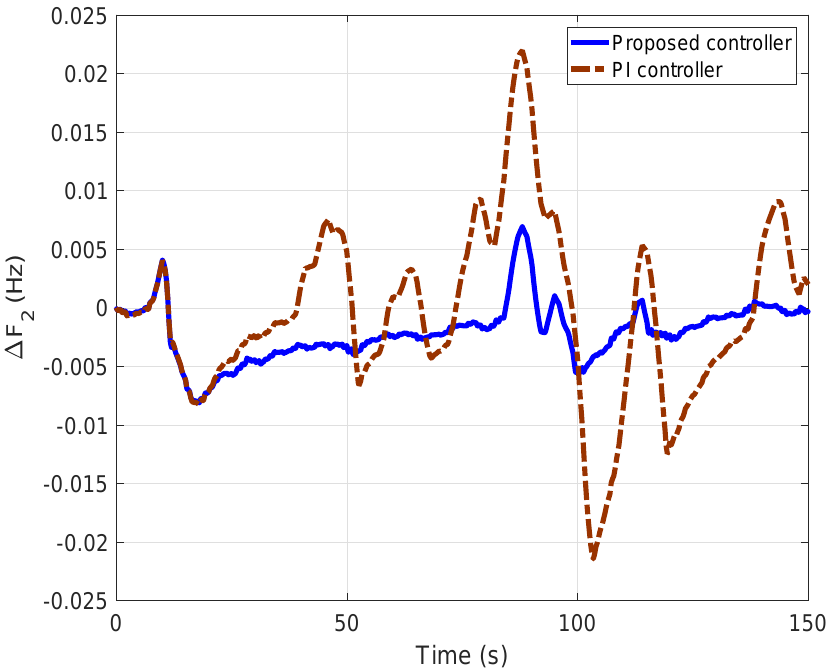
Figure 17. Frequency deviation in area 2 with proposed controller and PI